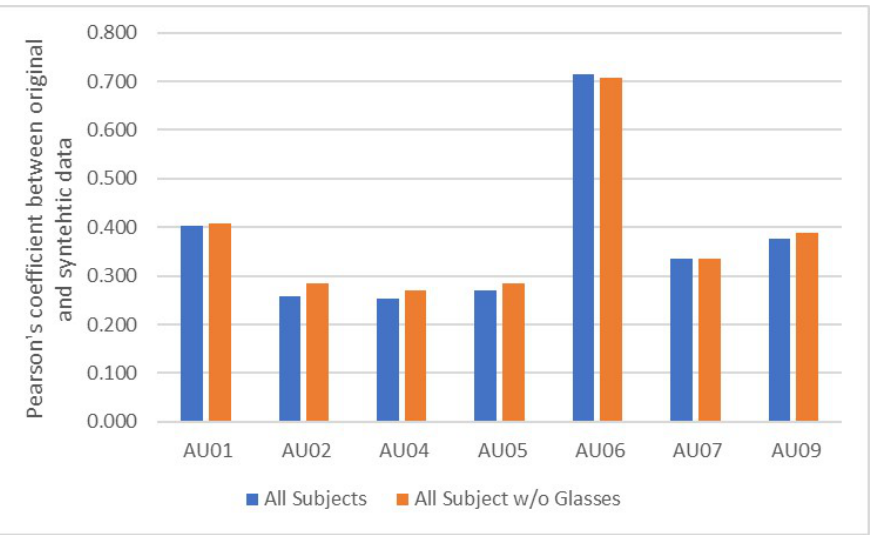
Figure 5. Comparison of Pearson’s correlation of upper face AUs between all participants and those without glasses. By excluding participants with glasses, most of the upper face AUs